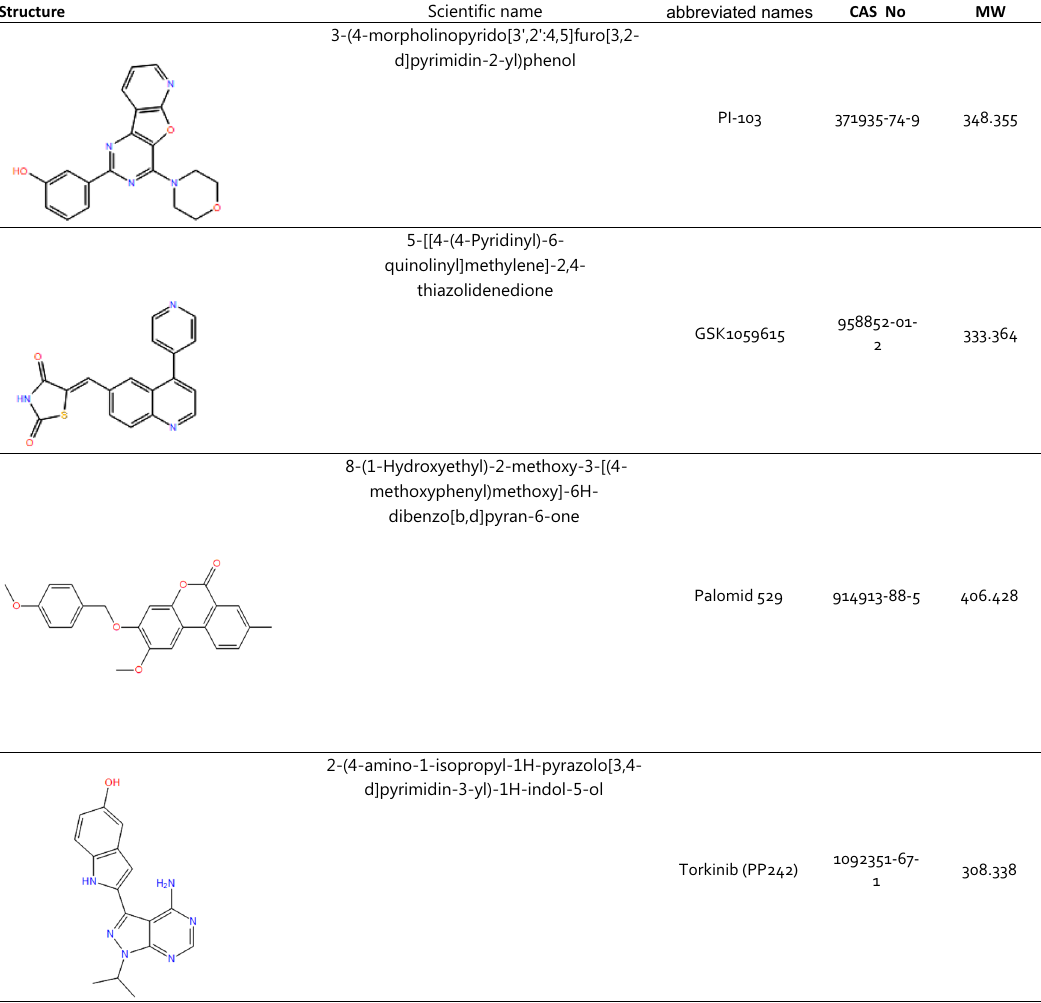
Table 1 Name, CAS number and chemical structure of the drugs